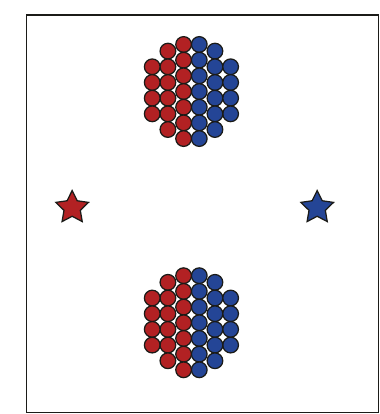
Figure 3: Symmetrical distribution of sample